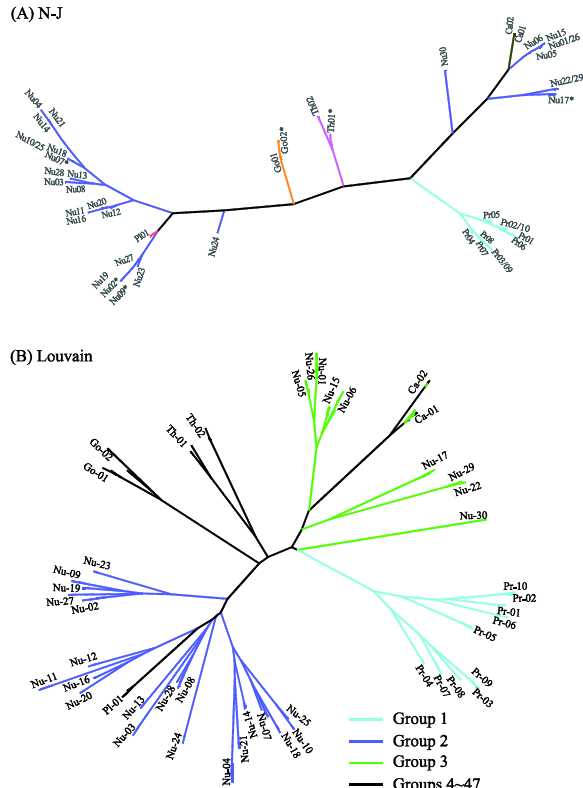
Figure 8. Distance-based phylogenetic trees of the GPCR network, as constructed by the N-J method ( A ) and by the Louvain method ( B ). In ( A ), each branch is colored according to GPCRdb’s classification. The * symbol denotes the splitting of a cluster into two sub-clusters. In ( B ), the first three groups are colored with distinct colors, while groups 4–47 are colored in black.